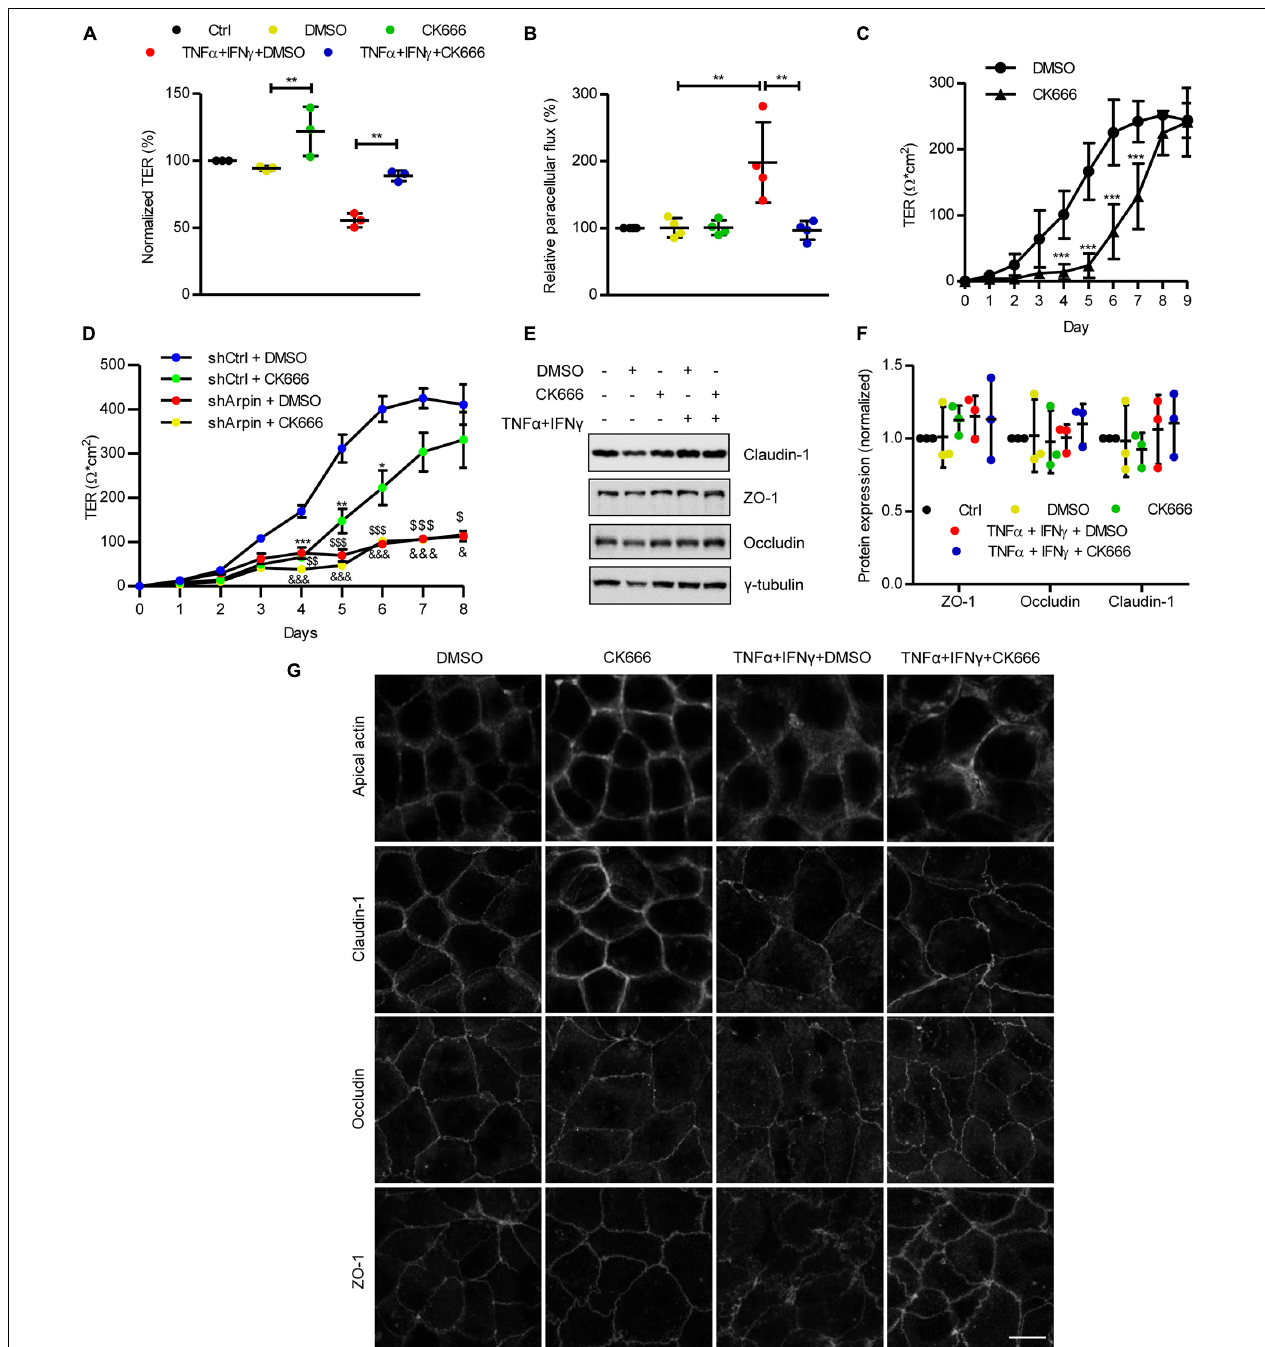
FIGURE 5 | CK666 reinforces the epithelial barrier. (A) Transepithelial electrical resistance (TER) measurements of confluent Caco-2 cells treated or not for 48 h with tumor necrosis factor (TNF) α /interferon (IFN) γ and CK666. The vehicle dimethylsulfoxide (DMSO) was used as control ( n = 3; one-way ANOVA). (B) Paracellular flux of confluent Caco-2 cells treated or not for 48 h with TNF α /IFN γ and CK666 was measured 2 h after adding 4 kDa fluorescein isothiocyanate (FITC)-dextran; color code as in panel (A) ; n = 4; one-way ANOVA. (C) Time-course TER measurements of sparse Caco-2 cells in the presence or absence of CK666 ( n = 5; two-way ANOVA). (D) Time-course TER measurements of sparse control and arpin-depleted Caco-2 cells in the presence or absence of CK666 ( n = 6; two-way ANOVA). Data are compared with shCtrl DMSO-treated cells (* p vs. shCtrl + CK666, $ p vs. shArpin + DMSO, and & p vs. shArpin + CK666). (E) Western blot for claudin-1, zonula occludens 1 (ZO-1), and occludin of Caco-2 monolayers treated or not with TNF α /IFN γ in the presence or absence of CK666. (F) Densitometry analysis of panel (D) ( n = 3; one-way ANOVA with Bonferroni’s correction). (G) Confocal microscopy analysis of apical actin, claudin-1, occludin, and ZO-1 in Caco-2 cells treated or not with TNF α /IFN γ and CK666; n = 3. Bar = 10 µ m. ** p < 0.01; *** p < 0.001.